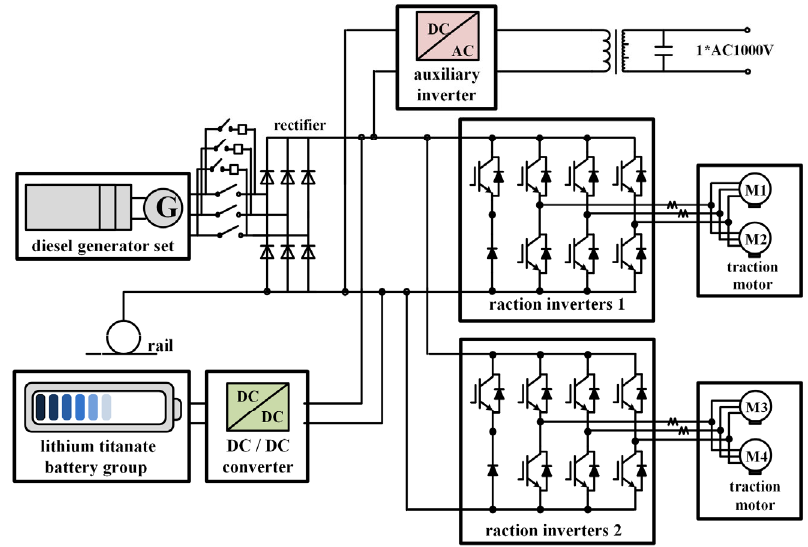
Figure 1. Topological structure of HPS for shunting locomotive.